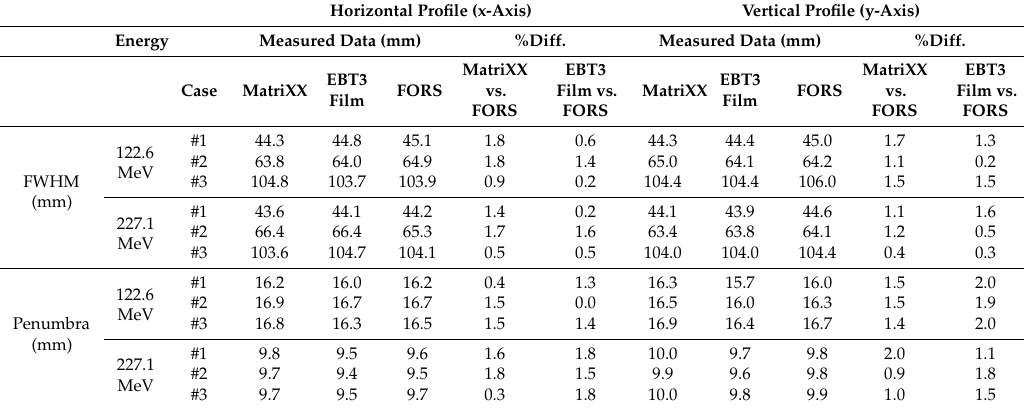
Table 1. Profiles for square-shaped fields, including FWHM and penumbra, using MatriXX, EBT3 film, and